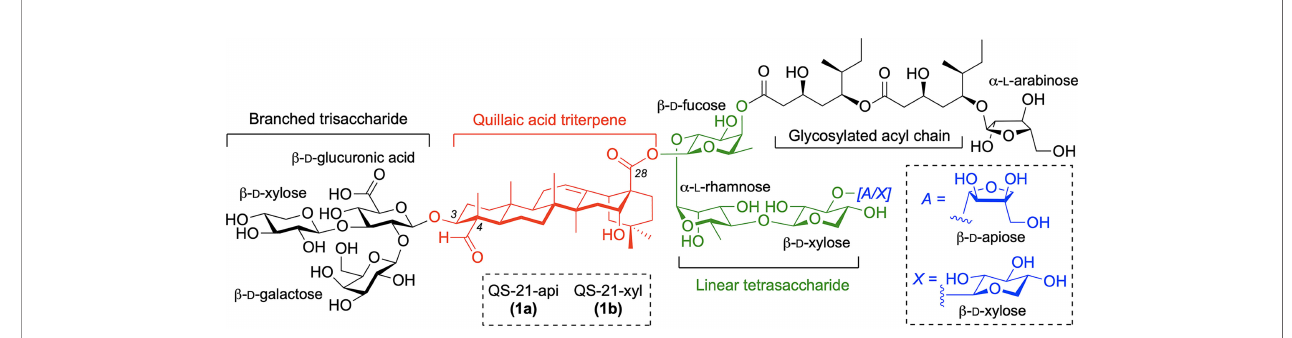
FIGURE 1 | Structure of QS-21 saponin natural product adjuvant ( 1a / 1b ) with its four